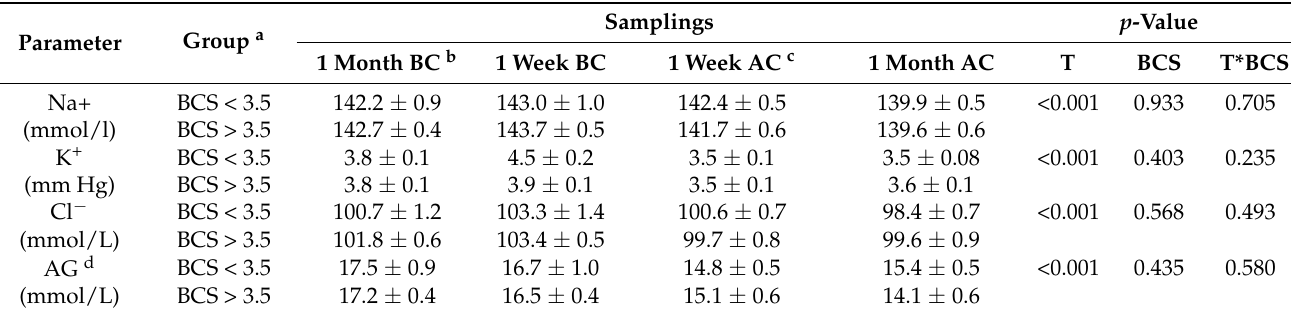
Table 4. Mean values ( ± standard error of the mean, SEM) of blood electrolytes depending on BCS group, time of sampling, and their interactions during the study